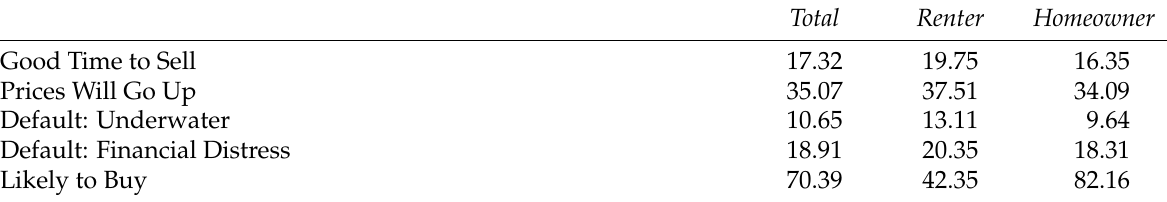
Table 1: Housing market expectations and attitudes by homeownership